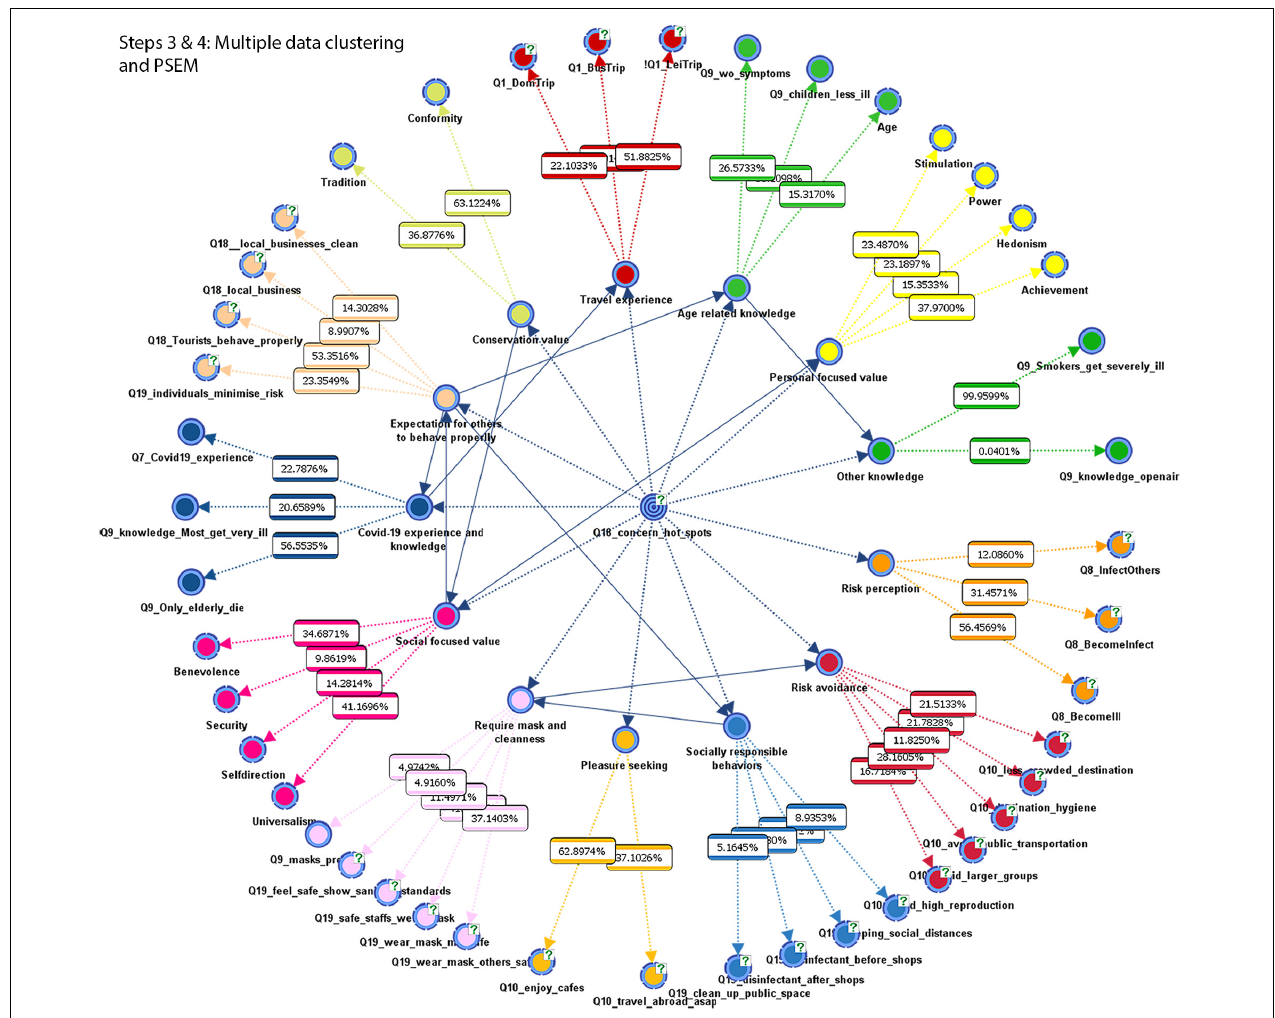
FIGURE 6 | Step 4: Overall links between target node and the 13 latent factor variables as well as links across the 13 latent factor variables obtained by